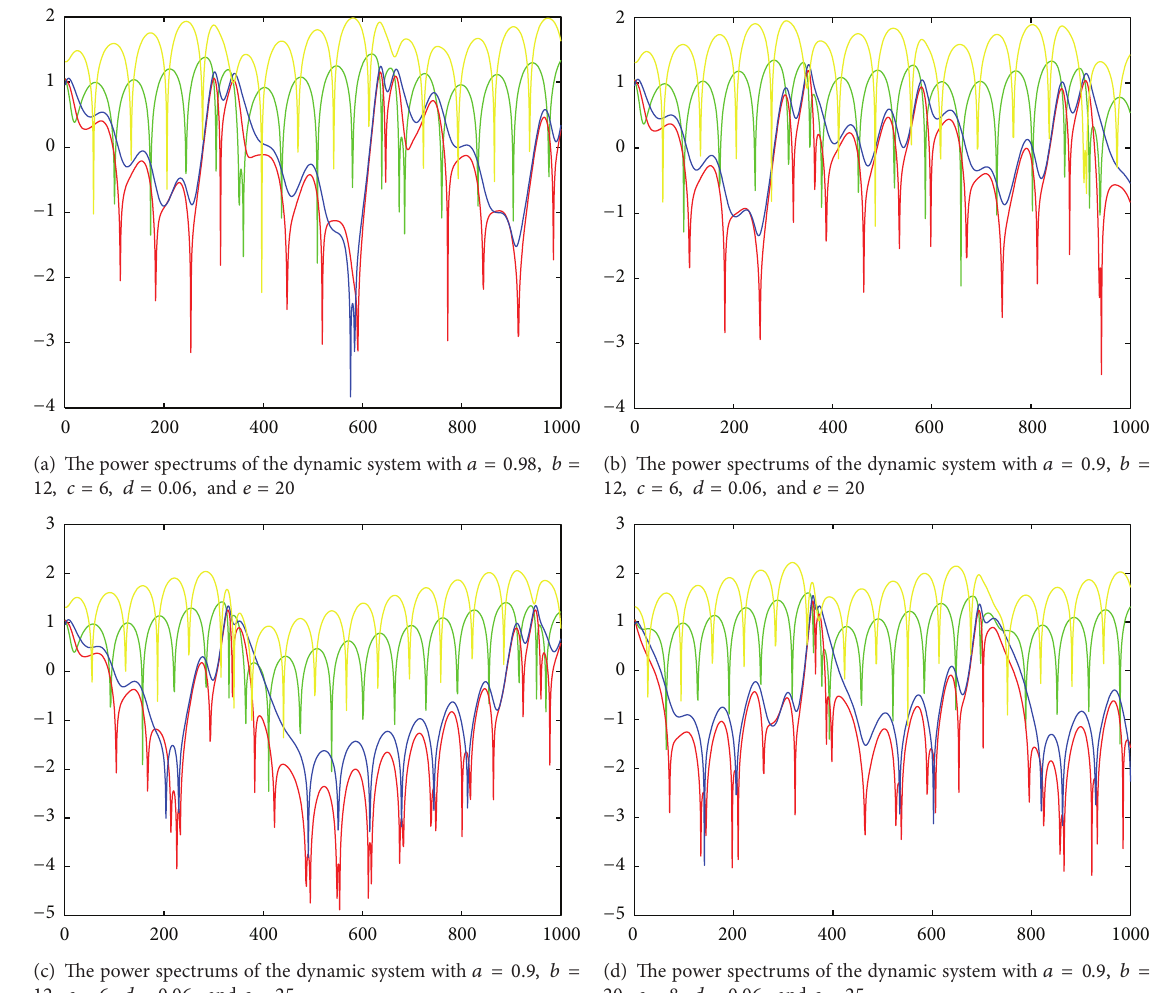
(b) The power spectrums of the dynamic system with 𝑎 = 0.9, 𝑏 = 12, 𝑐 = 6, 𝑑 = 0.06, and 𝑒 = 20